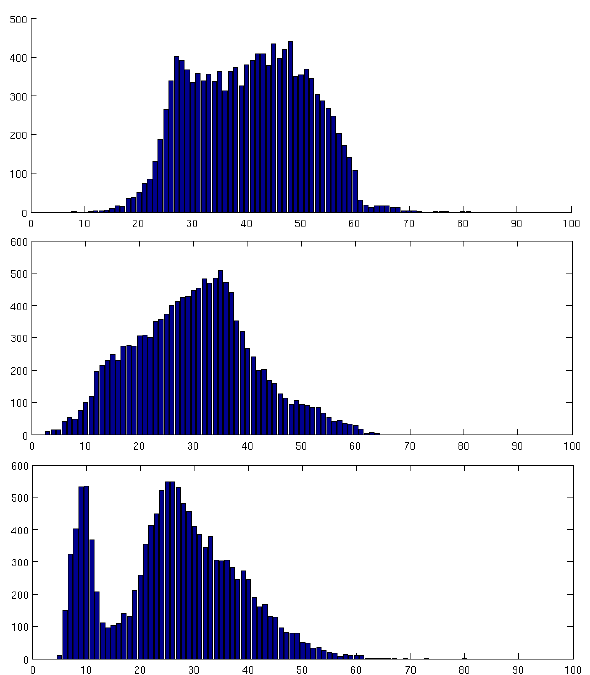
Figure 8: Histograms of the CCH mean values from 12834 vege- tation patches in the HSV color space. From top to bottom: H, S, V.